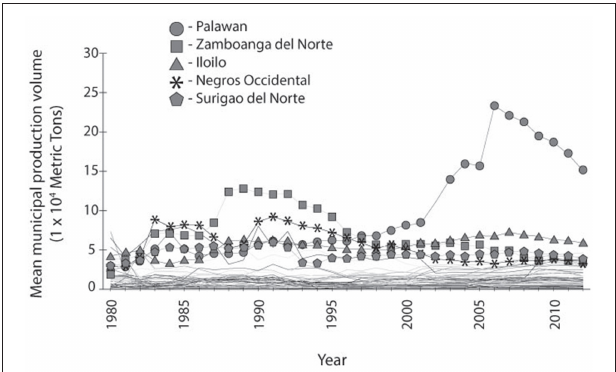
FIGURE 4 | Time-series data of Philippine marine municipal fish catch highlighting the top five fish-producing provinces (indicated by symbols and legends) from 1980 to 2012. Other provinces are represented as lines without symbols, and generally showed much lower fisheries production than the top five